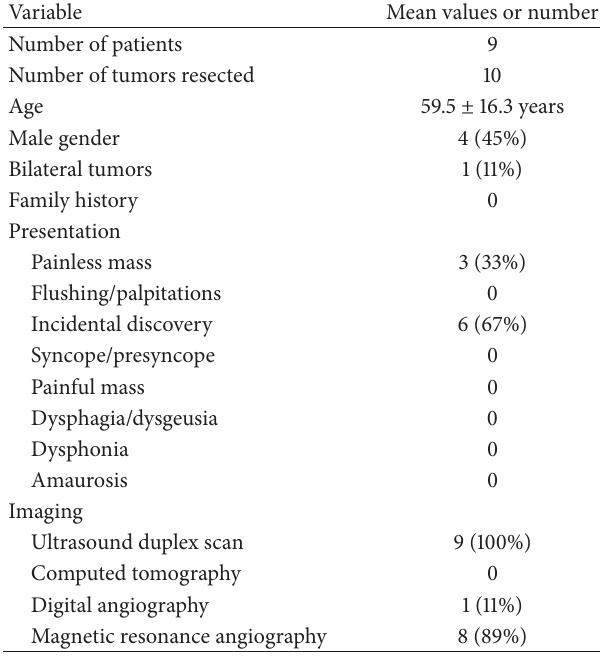
Table 1: Demographic data of patients included in the study.